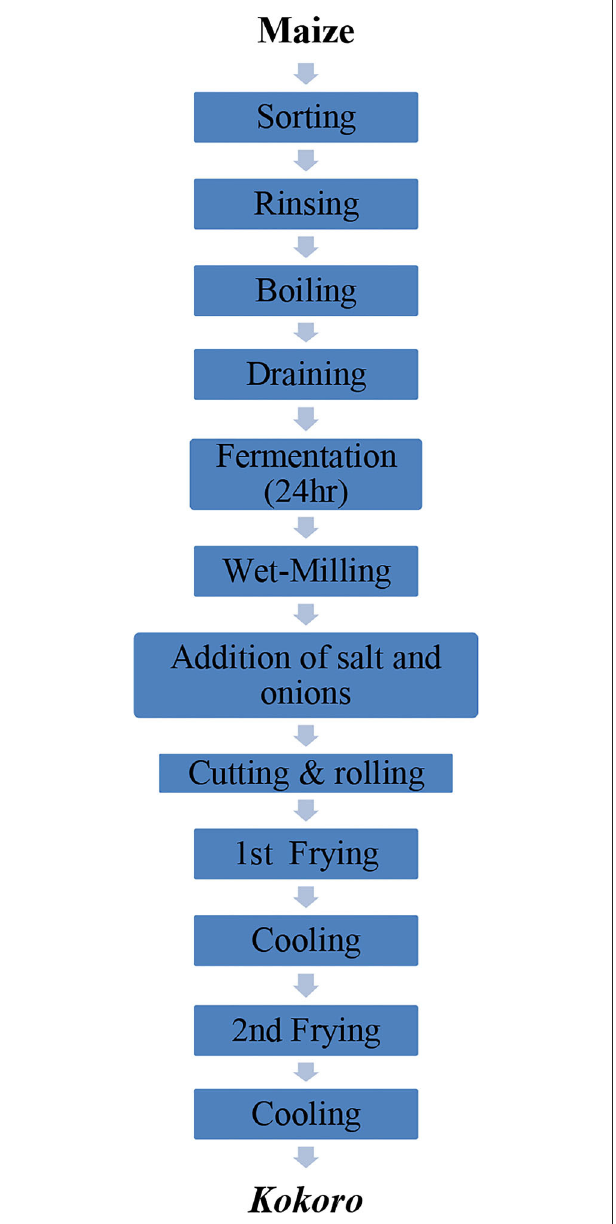
FIGURE 1 | Flowchart for traditional Kokoro